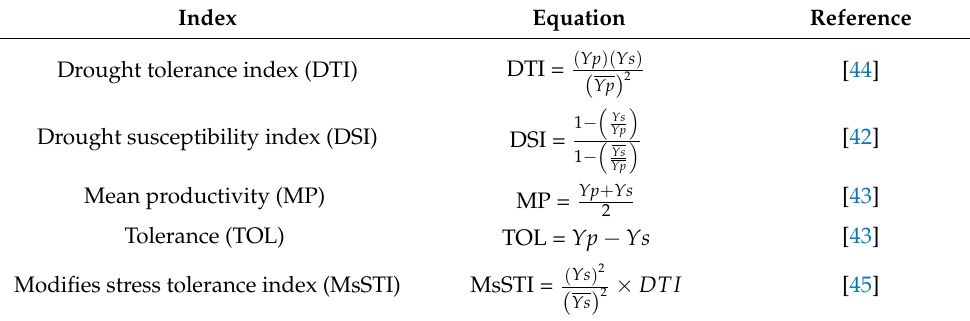
Table 2. Equations and references of the drought tolerance and susceptibility indices used for drought tolerance